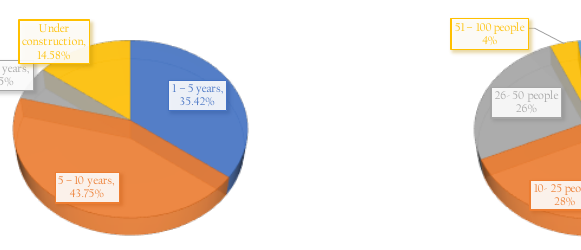
Figure 2. Maturity and size of FinTech